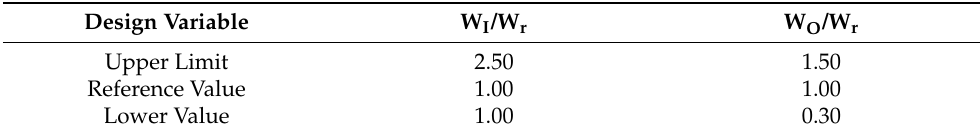
Table 3. Design variables and ranges.